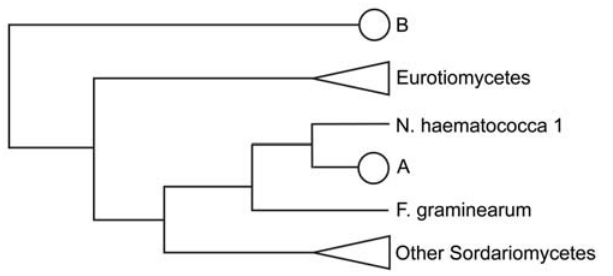
Figure 2. Phylogenetic placement of paralogs in N.haemato- cocca MPVI. N. haematococca 1 is the ortholog. (A) Placement of a gene at this position implies a recent gene duplication. (B) Placement of a gene at this position indicates the gene may be a pseudoparalog.